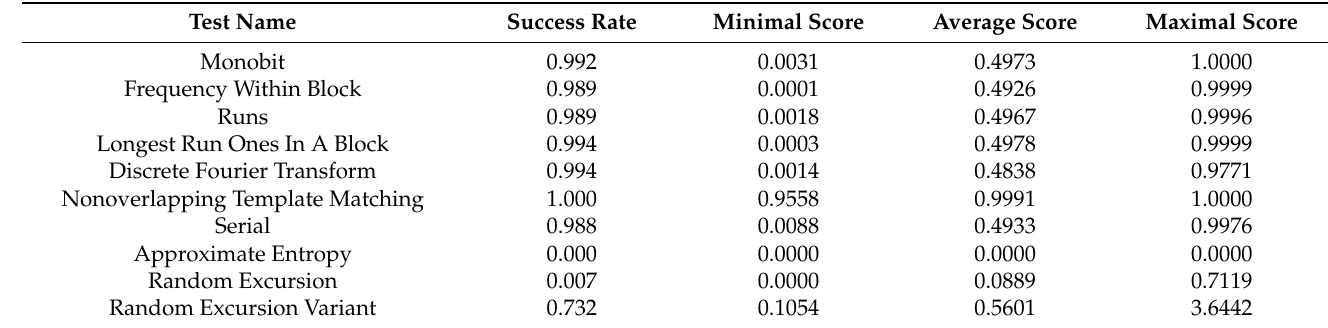
Table 1. The results of NIST